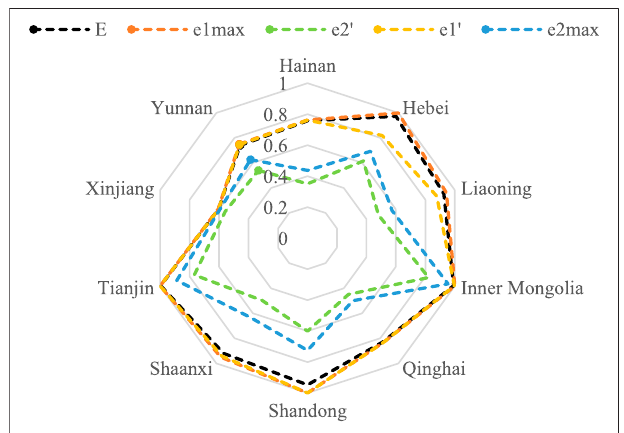
FIGURE 2 | Water – energy nexus system ef fi ciency. IP and WT sub- ef fi ciencies in 14 provinces.